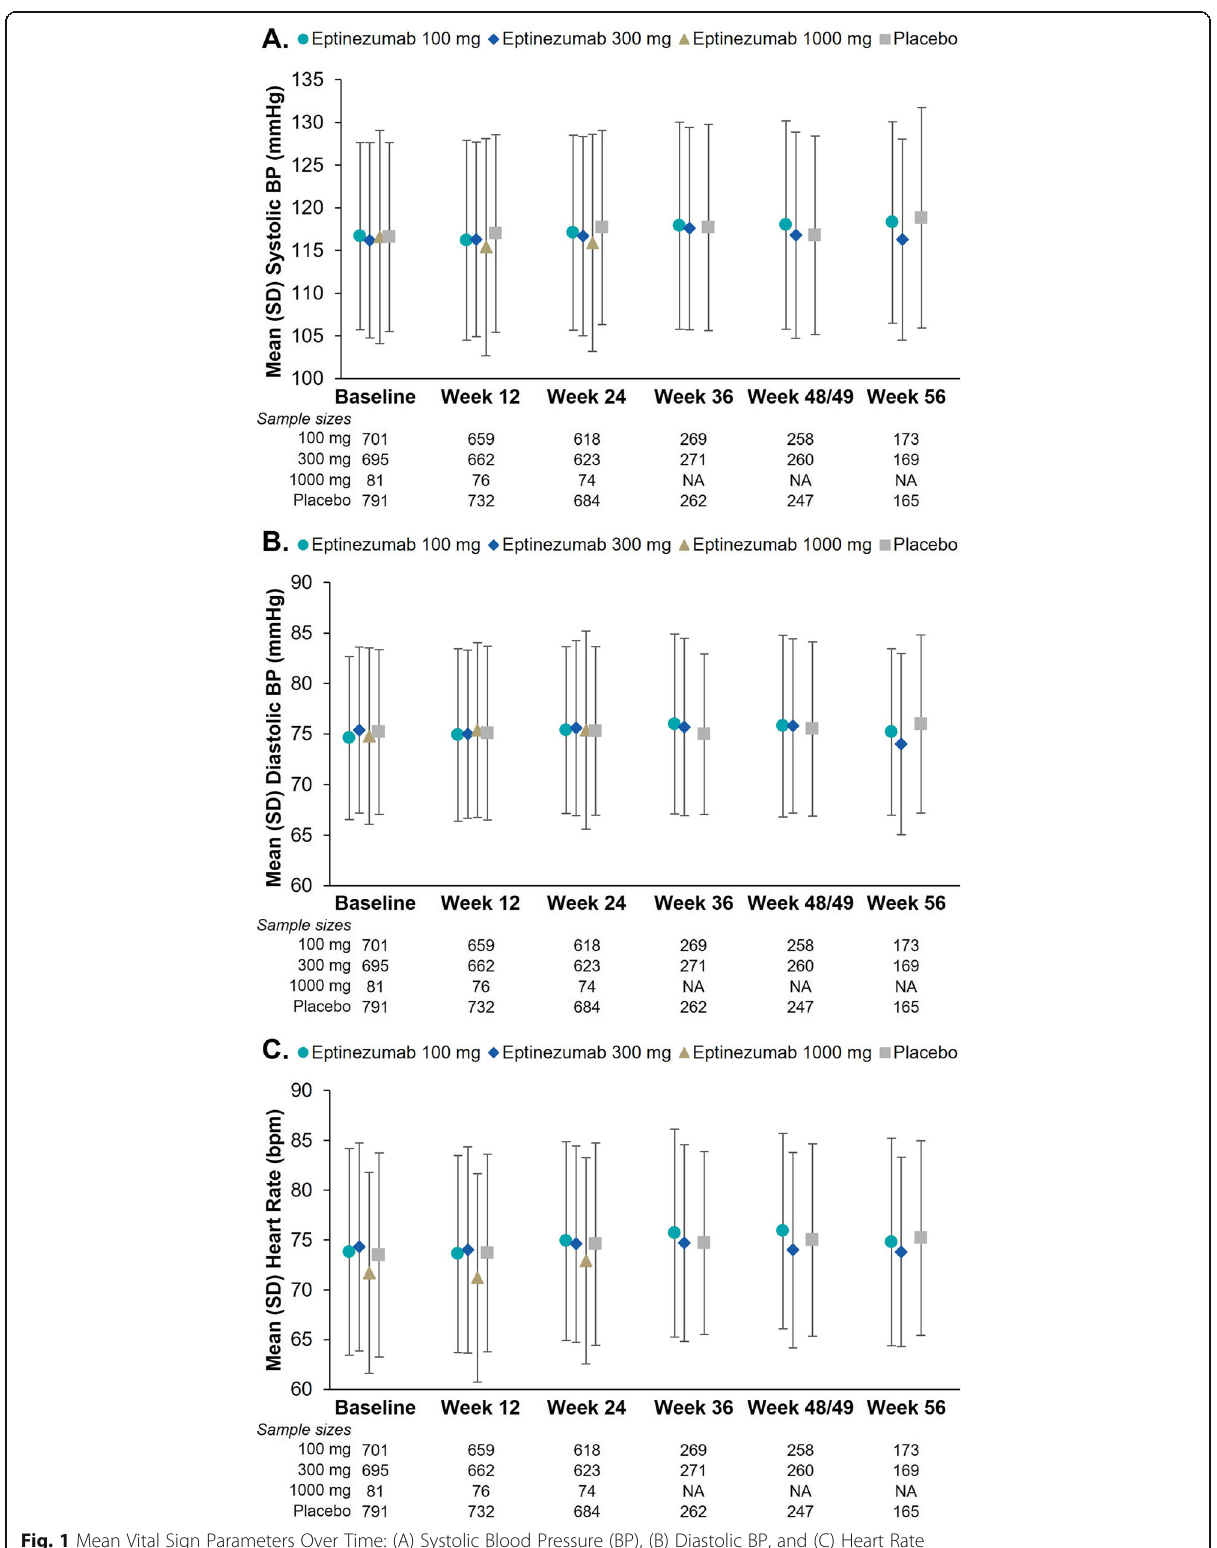
Fig. 1 Mean Vital Sign Parameters Over Time: (A) Systolic Blood Pressure (BP), (B) Diastolic BP, and (C) Heart